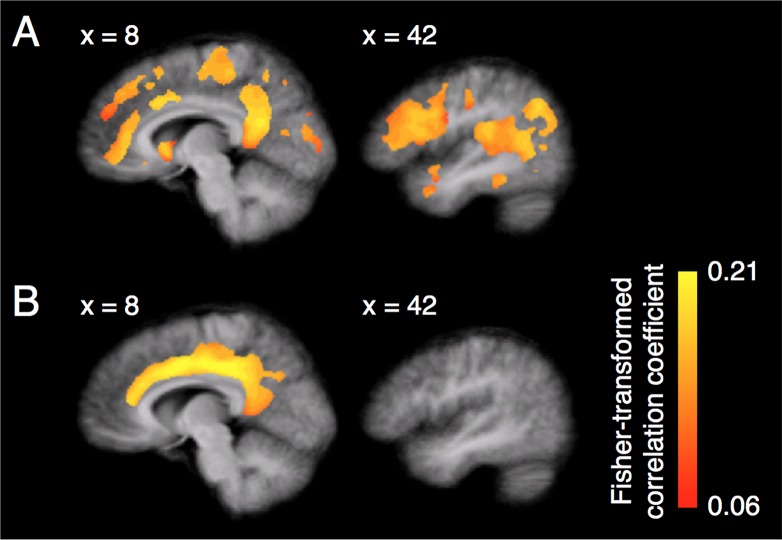
Results of a leak analysis using a searchlight method.(A) Mean map of Fisher-transformed correlation coefficients between the estimated preference ratings in the CC and its reconstructed values based on activation patterns of voxels in each searchlight sphere across subjects during the fMRI decoder construction stage. (B) Mean map of the Fisher-transformed correlation coefficients during the induction stage. Subjects from the higher- and lower-preference groups were combined (n = 24). In both (A) and (B), only the voxels showing significant correlation coefficients are highlighted in colors here (one-sample two-tailed t-test on z-scores of the correlation coefficients after permutation, p < 0.05, Bonferroni corrected; see Permutation Test in Materials and Methods for details of calculation of z-scores).